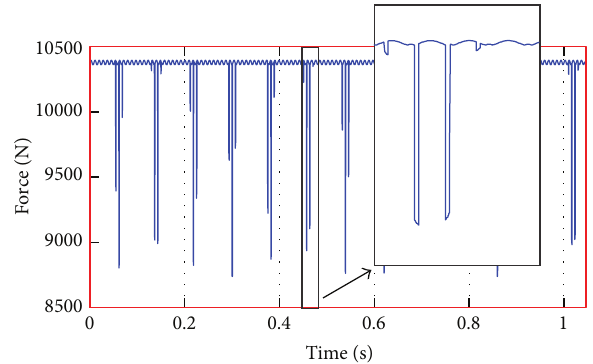
Figure 15: Bearing time domain force profile plot for inner race defect in vertical direction.